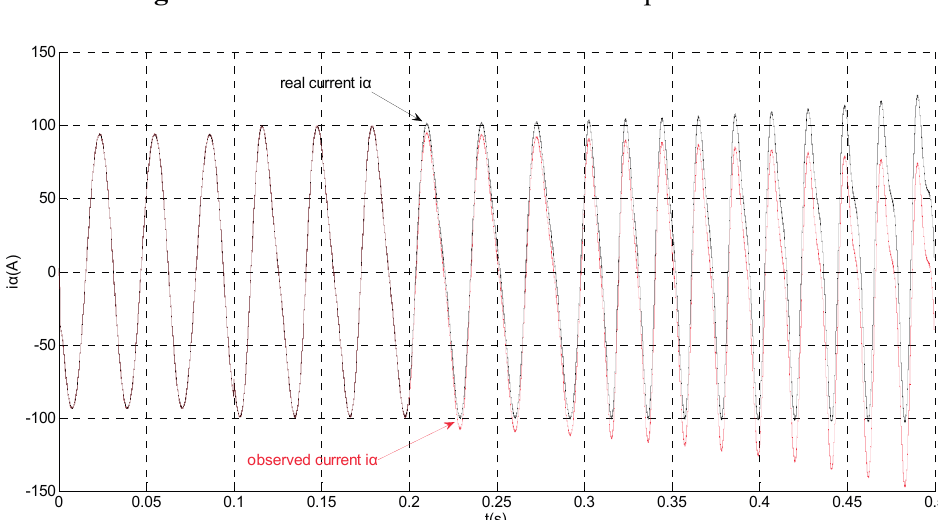
Figure 19. Simulation results of the actual and observation of α axis stator